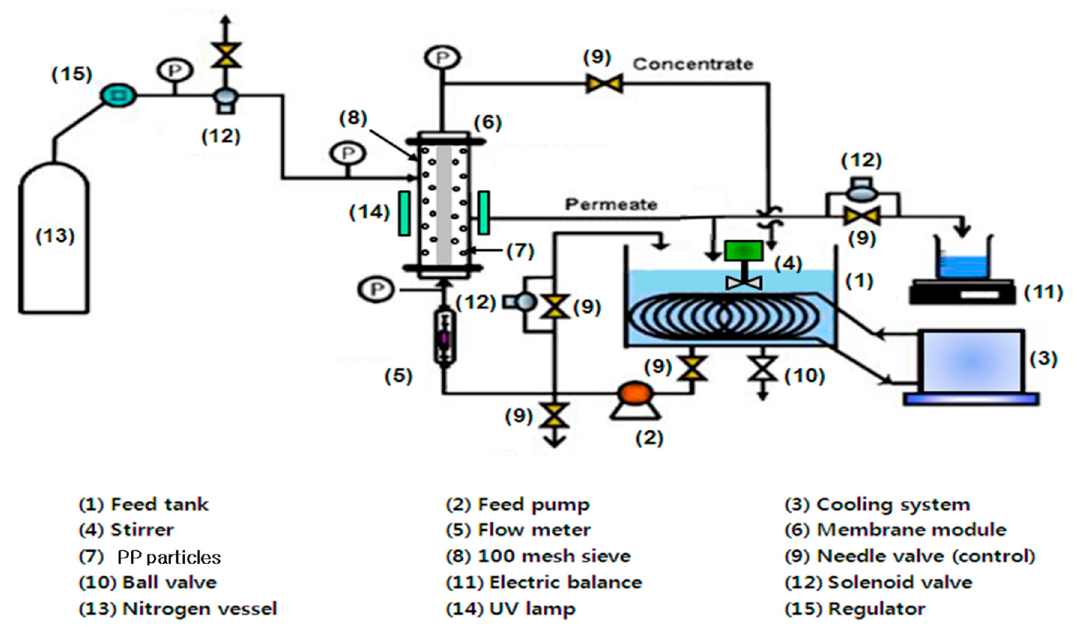
Figure 1. Apparatus of the integrated water treatment system, of tubular multichannel alumina ceramic microfiltration and pure polypropylene particles, using periodic air backwashing and UV radiation.